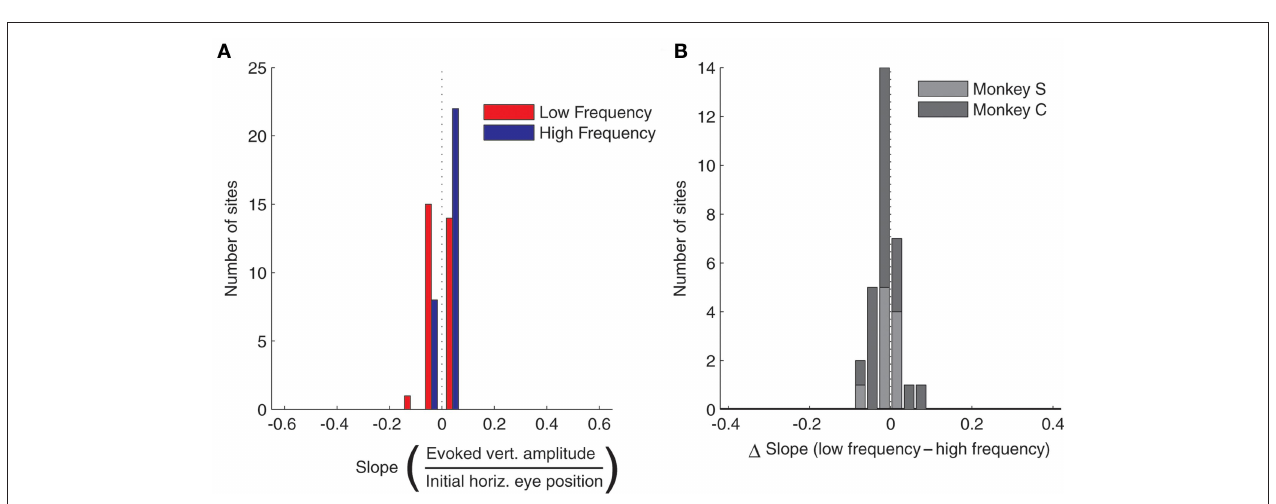
frequency stimulation conditions. The horizontal axis has been scaled to match Figure 3A for comparison purposes. (B) Differences in slope between low and high frequency conditions. Horizontal axis has been scaled to match Figure 3B